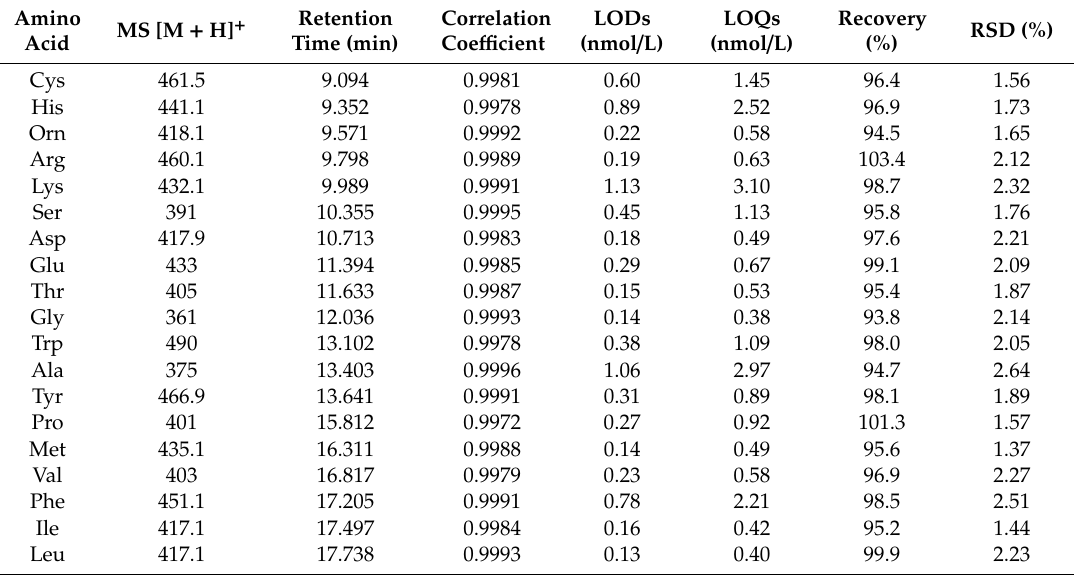
Table 1. Molecular ions [M + H] + , retention time, correlation coe ffi cients, limits of detection, limits of quantification, recovery, and precision values of amino acid